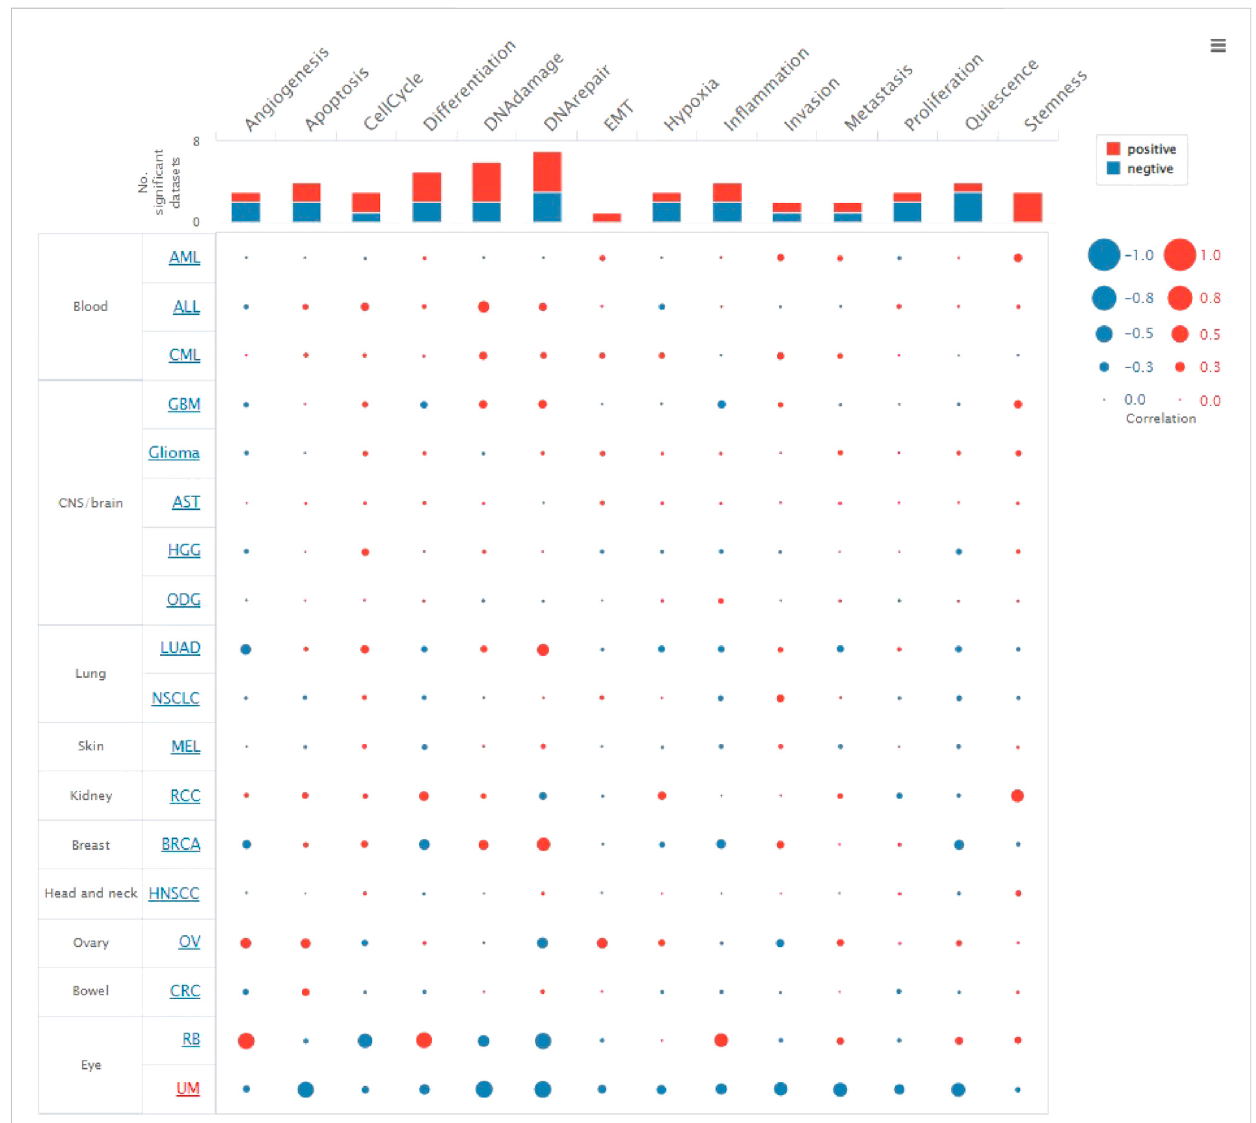
FIGURE 9 The correlations of 14 tumor biological functions with